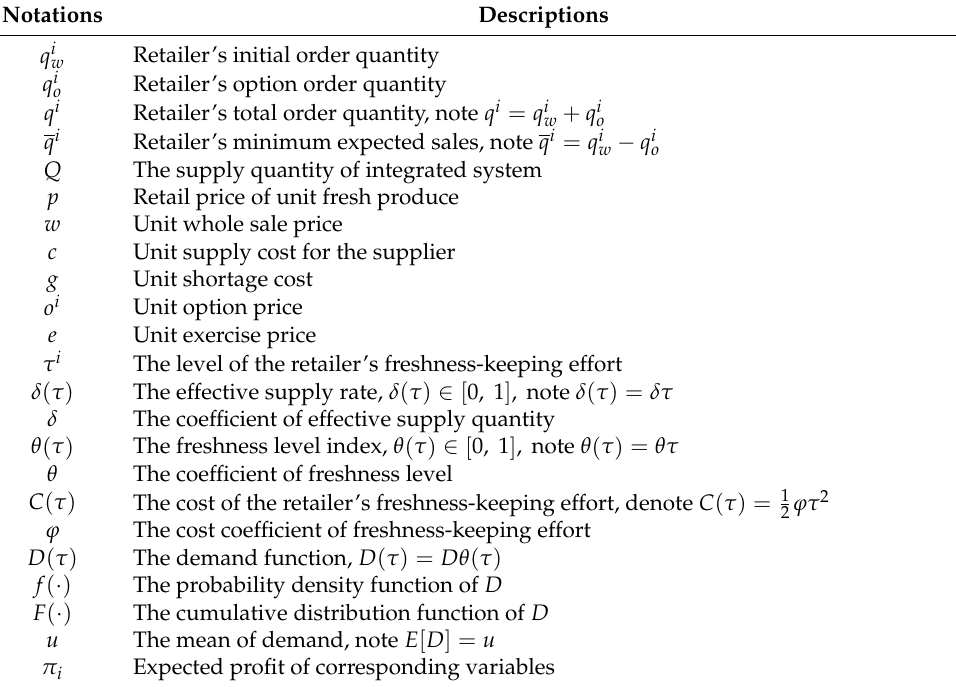
Table 2. Notation and